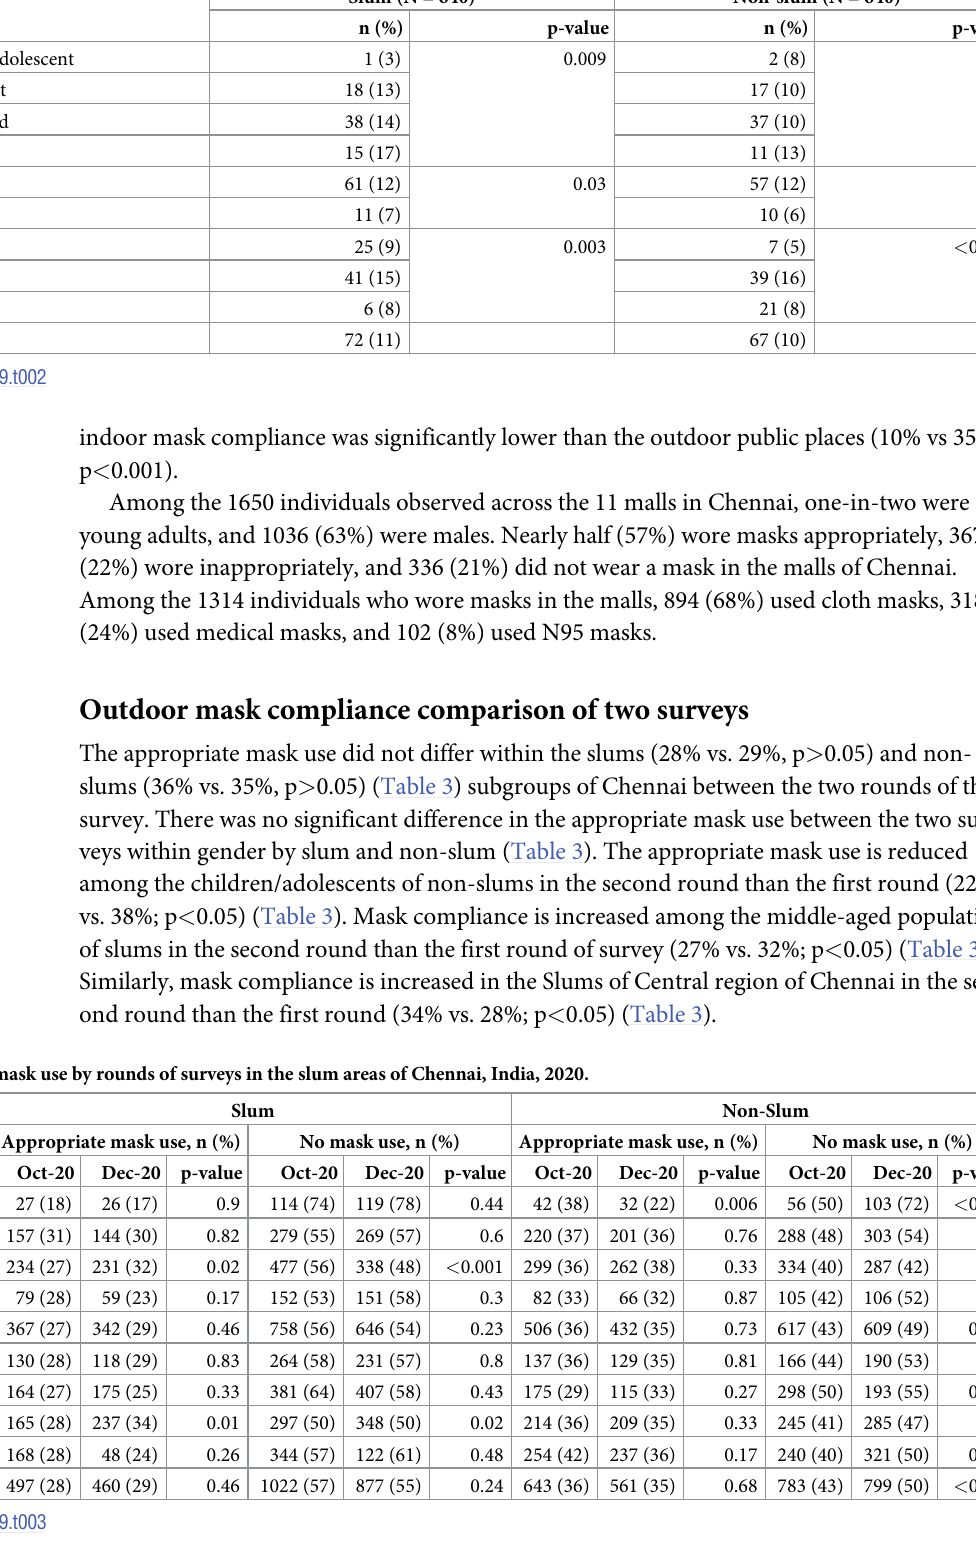
Table 2. Indoor mask compliance in public places in the slum and non-slum areas by age group, gender, and region, Greater Chennai Corporation, Tamil Nadu, India, December 2020. Characteristics